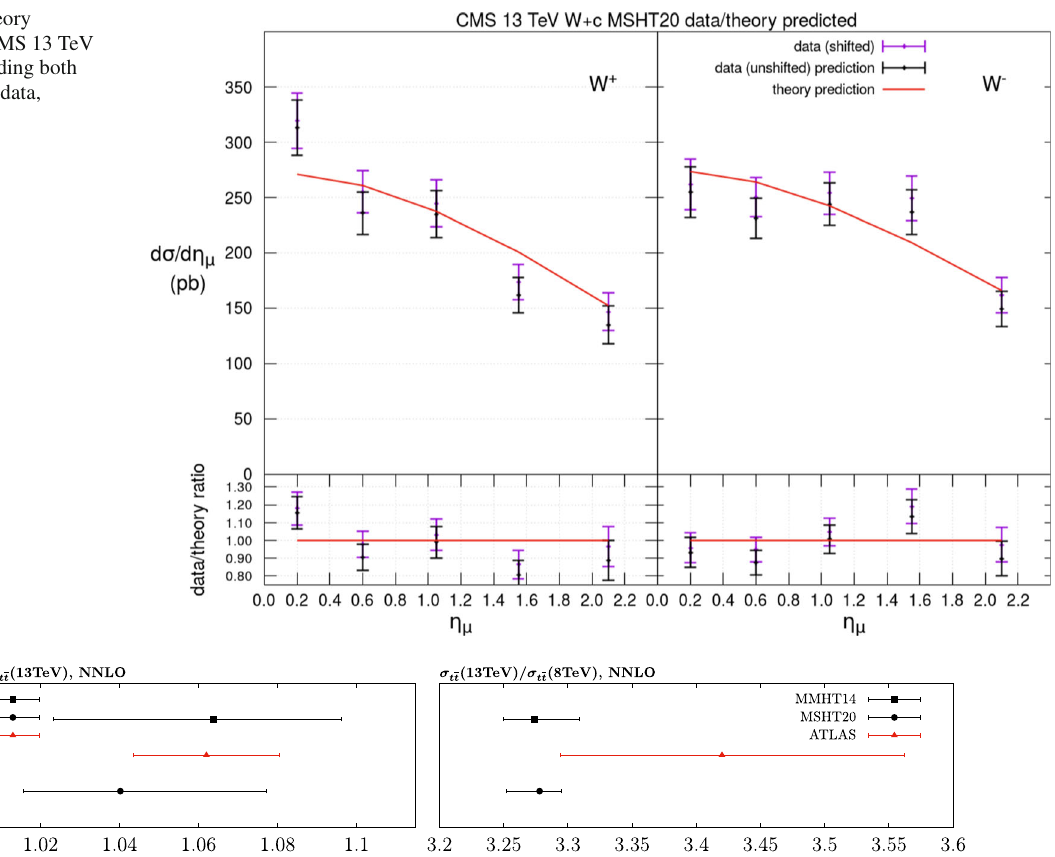
Fig. 84 MMHT14 and MSHT20 NNLO predictions for the cross sec- tion ratios of Z → ll production (with p l ⊥ > 25 GeV, | η l | < 2 . 5) and the t t total cross section, compared to data from ATLAS [30].